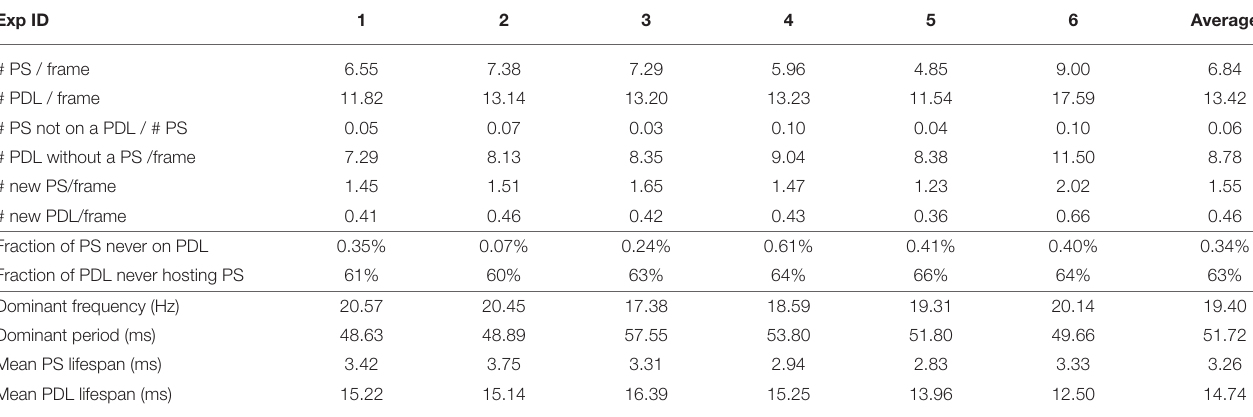
6 rabbit hearts using two cameras, such that the entire epicardial wall is =